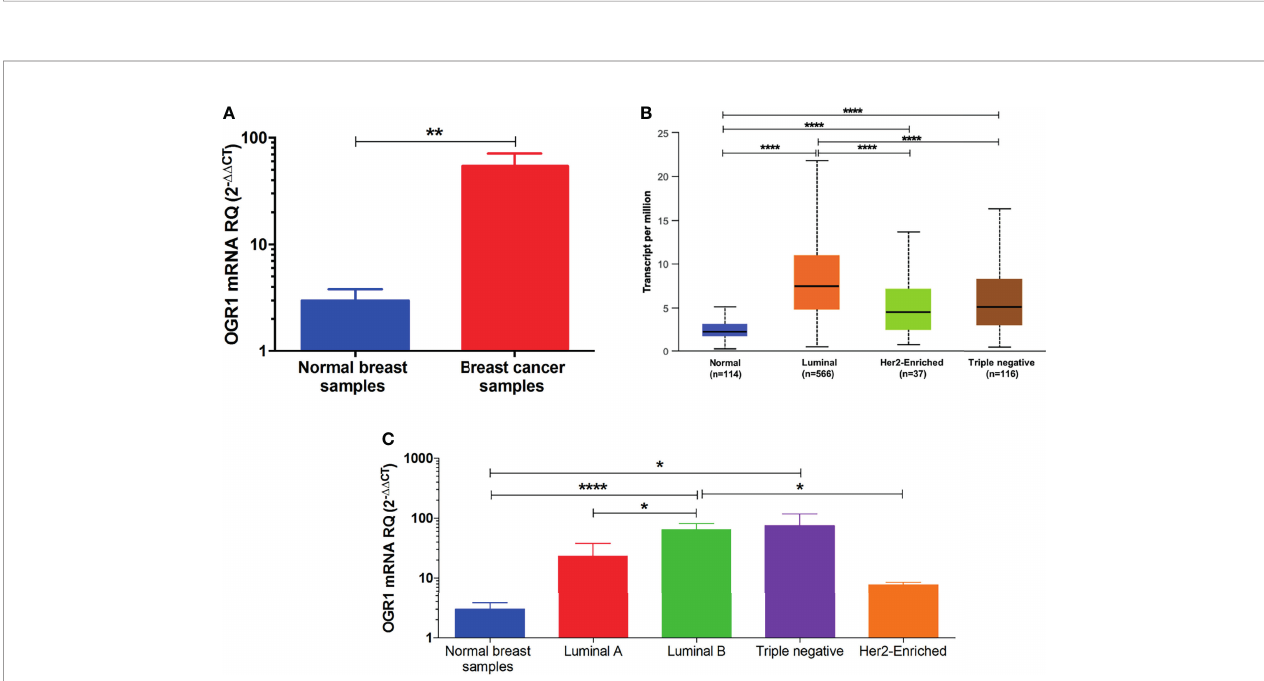
FIGURE 3 | Quanti fi cation of GPR68 mRNA expression in breast cancer patients using qRT-PCR. (A) GPR68 mRNA expression was upregulated in breast cancer tissue samples of the recruited cohort compared to their normal counterparts. (B) In-silico analysis of GPR68 among the various molecular subtypes of breast cancer. (C) Validation of GPR68 expression on the mRNA level in the luminal A, luminal B, Her2-enriched and triple-negative breast cancer subtypes. *p<0.05, **p<0.01,